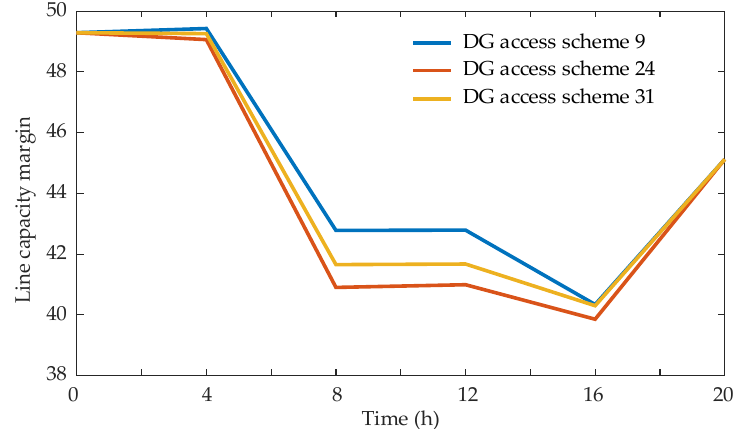
Figure 8. The line capacity margin of schemes 9, 24 and 31 under scenario 5.